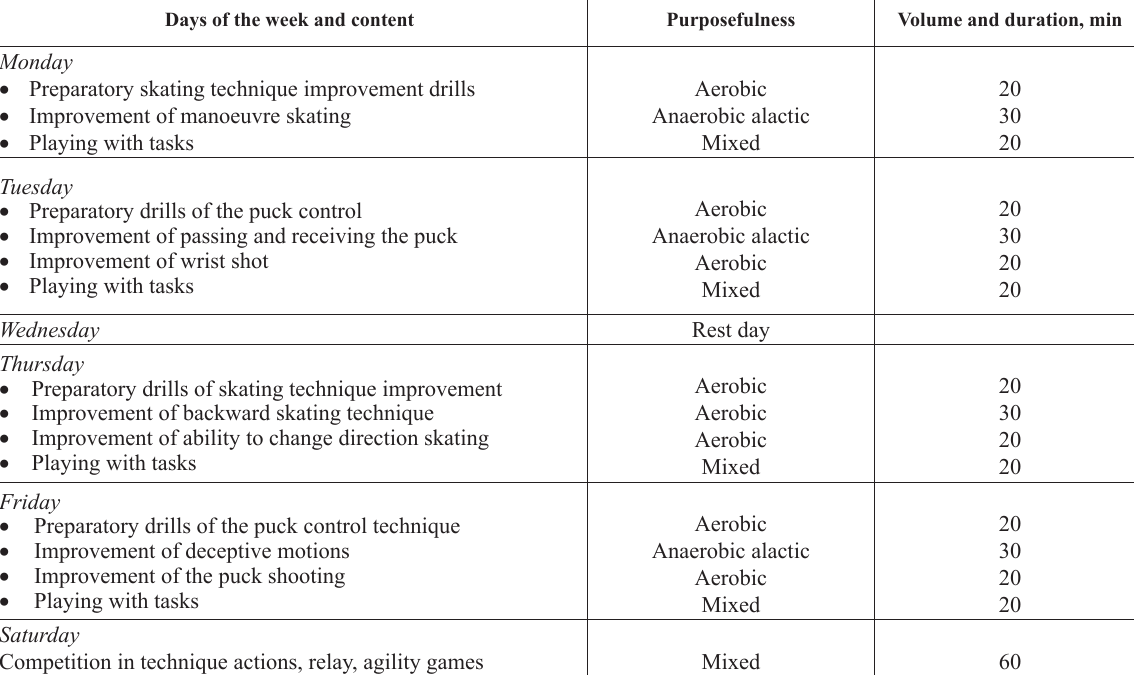
Table 1. Sample of micro-cycle weekly plan in the initial training period of the preparatory